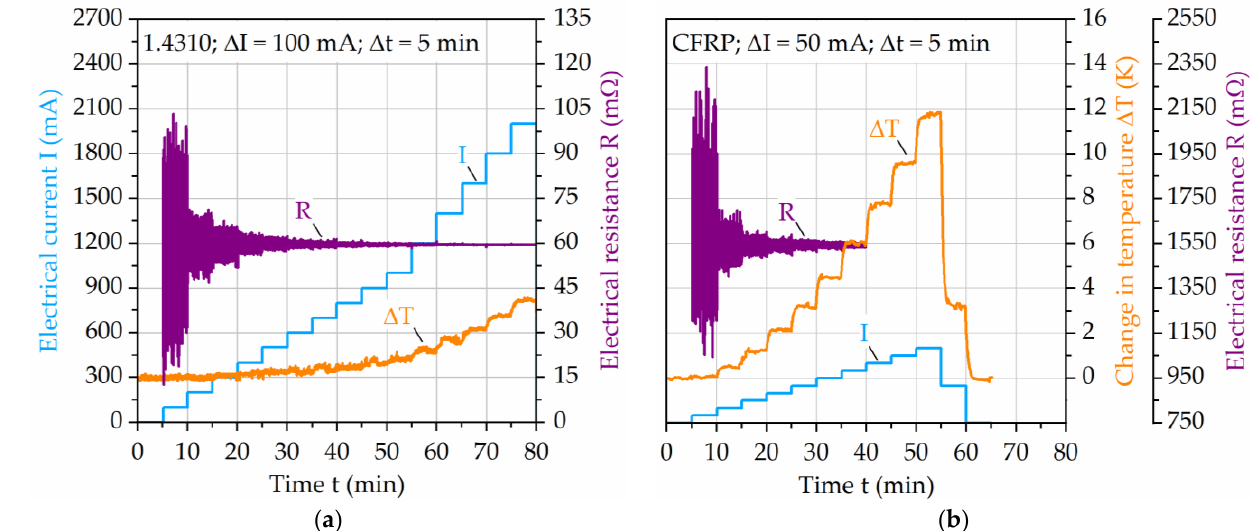
Figure 5. Influence of electrical current on the change in temperature of ( a ) 1.4310 and ( b ) carbon fiber reinforced PA6. The change in temperature axis in ( b ) is also valid for graph ( a ).